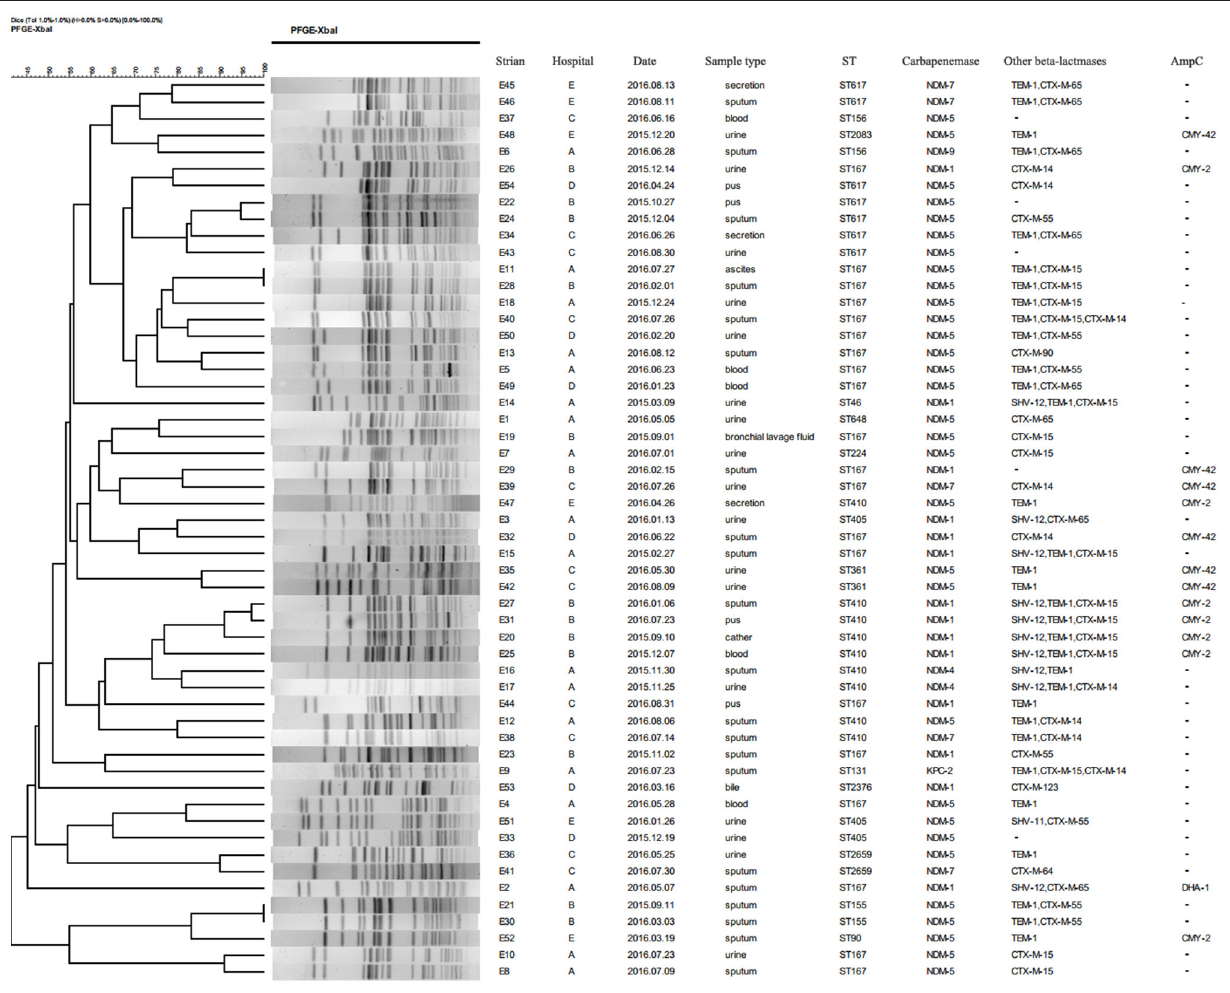
FIGURE 3 | Dendrogram of PFGE profiles of 54 CRECO isolates . The UPGMA algorithm was used to construct dendrogram based on the dice similarity coefficient. Isolates were categorized to be of the same cluster when their dice similarity index was ≥